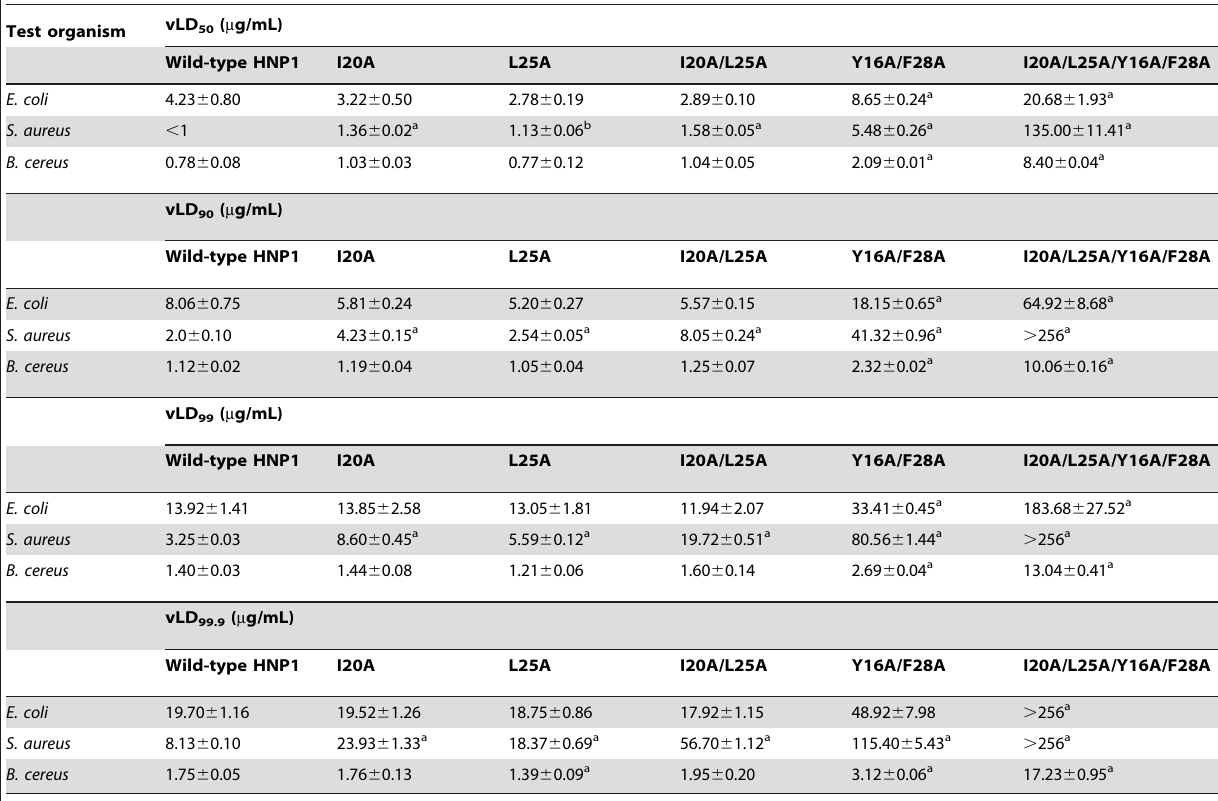
Table 3. Antibacterial activities of HNP1 and